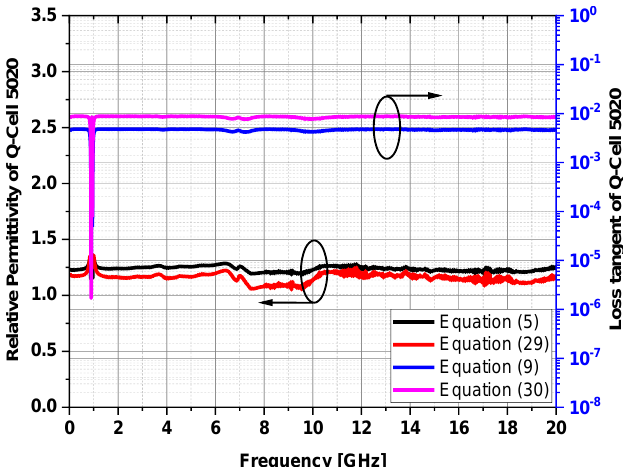
Figure 5. ( a ) The characteristic impedance of aquarium sand and polenta, using the circular coaxial fixture up to 10 GHz; ( b ) the characteristic impedance of PLA and semi-flex, using the rectangular coaxial apparatus up to 10 GHz; ( c ) the characteristic impedance of semolina, using the circular coaxial test cell up to 13.5 GHz.